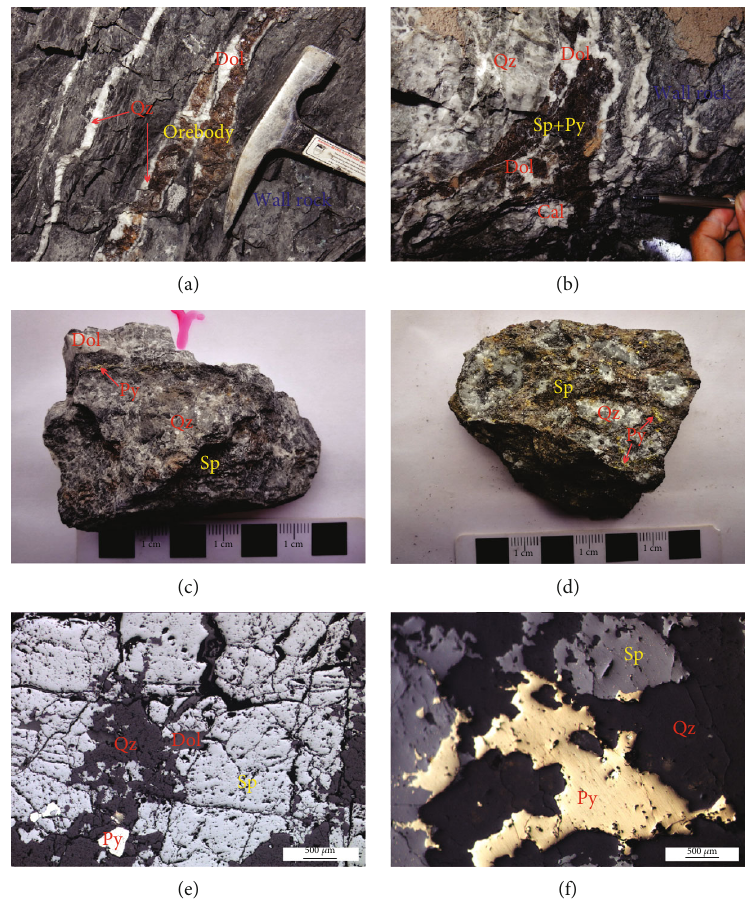
Figure 3: Field photos of ore bodies and wall rocks of the Laoyingqing Pb – Zn deposit. (a) The primary ore body in the silty and carbonaceous slate of the Huangcaoling Fm. in Mesoproterozoic Kunyang Group, and the distinctive boundary between the ore body and wall rocks. (b) The gangue quartz, calcites, and dolomites in primary ores. (c) Fine- to coarse-grained sphalerite (Sp)+lumpy and patch quartz (Qz)+vein pyrite (Py)+vein dolomite (Dol). (d) Fine-grained Sp+patch Qz+patch Py. (e) Coarse-grained Sp+cubic Py+vein Dol+quartz. (f) Fine- grained Sp+ fi ne-grained Py+quartz. Abbreviations: Sp: sphalerite; Py: pyrite; Qz: quartz; Dol: dolomite; Cal: